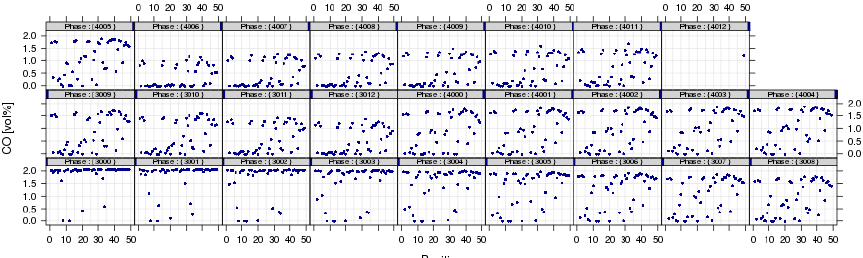
Figure 5. Average CO concentration for each individual reactor position after the initial data reduction step. The individual subplots correspond to the different experimental conditions shown in Figure 4.